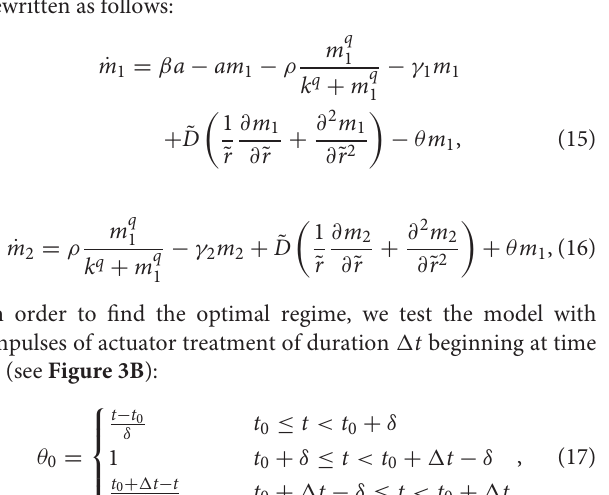
r = r p . In this work we assumed σ 1 = 0.3 mm and σ 2